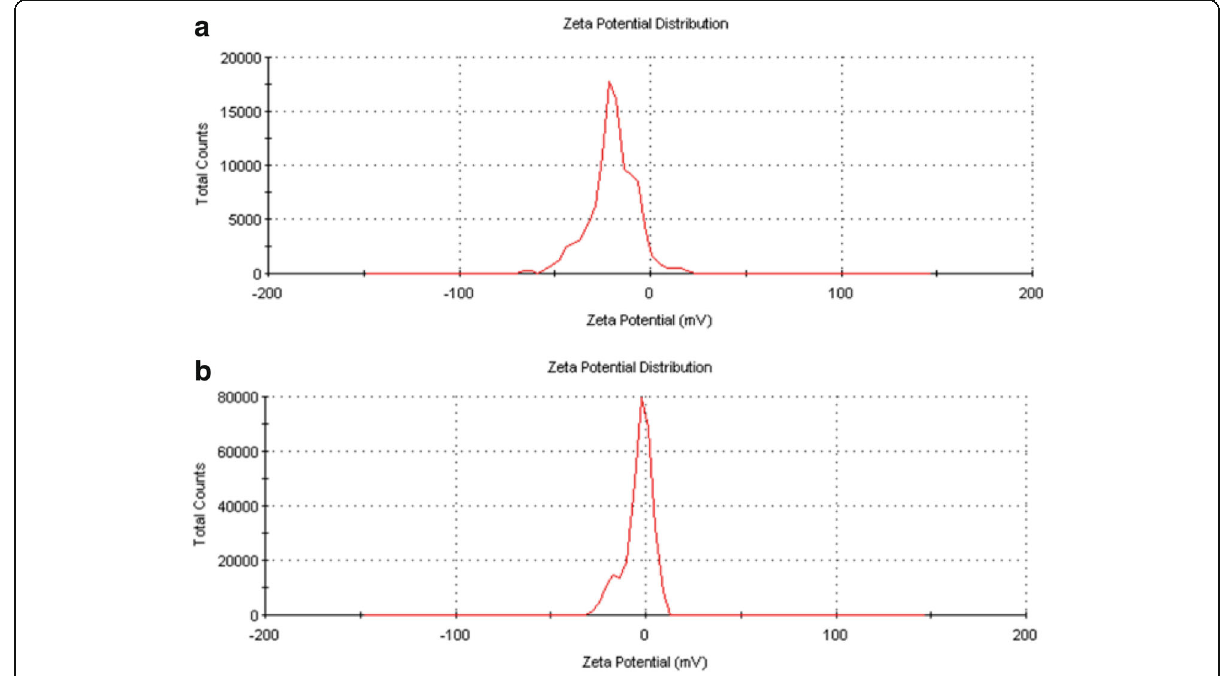
Fig. 9 Zeta potential of AgNPs synthesized by Trichoderma longibrachiatum fungal biomass of a 10 g and b 15 g after